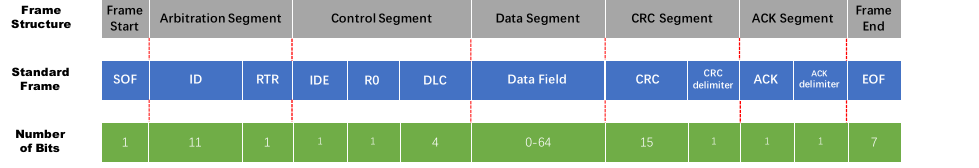
Figure 1. Structure of CAN